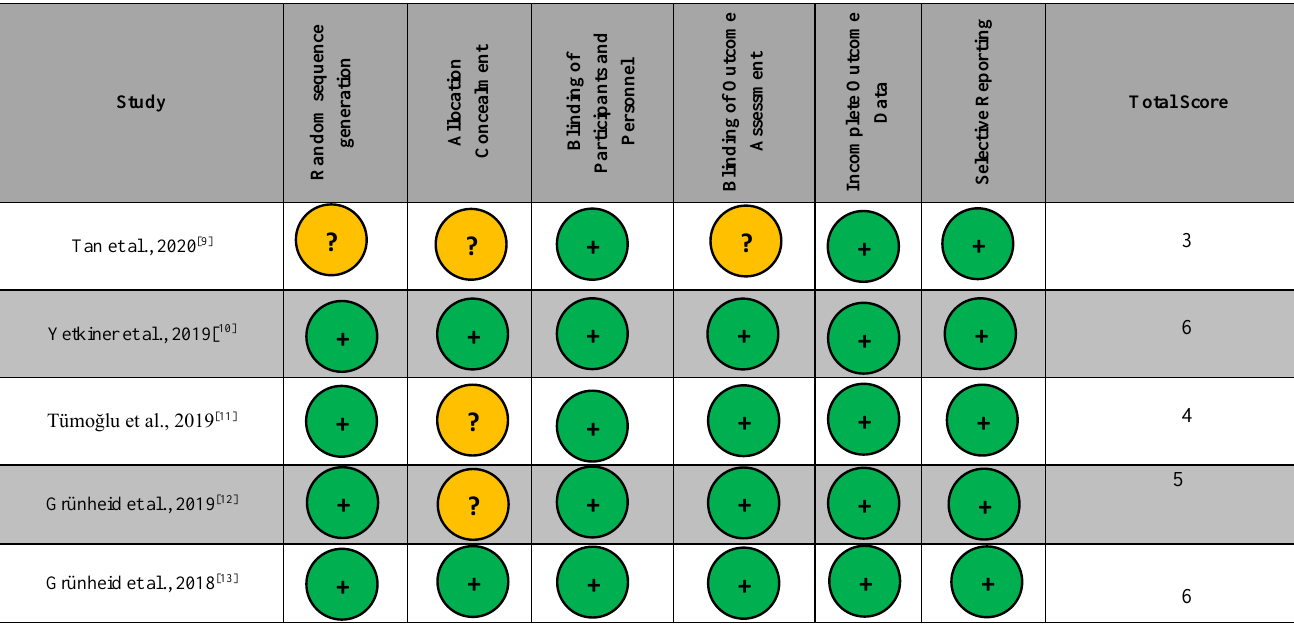
Table 3. Risk of bias assessment (Collaboration’s